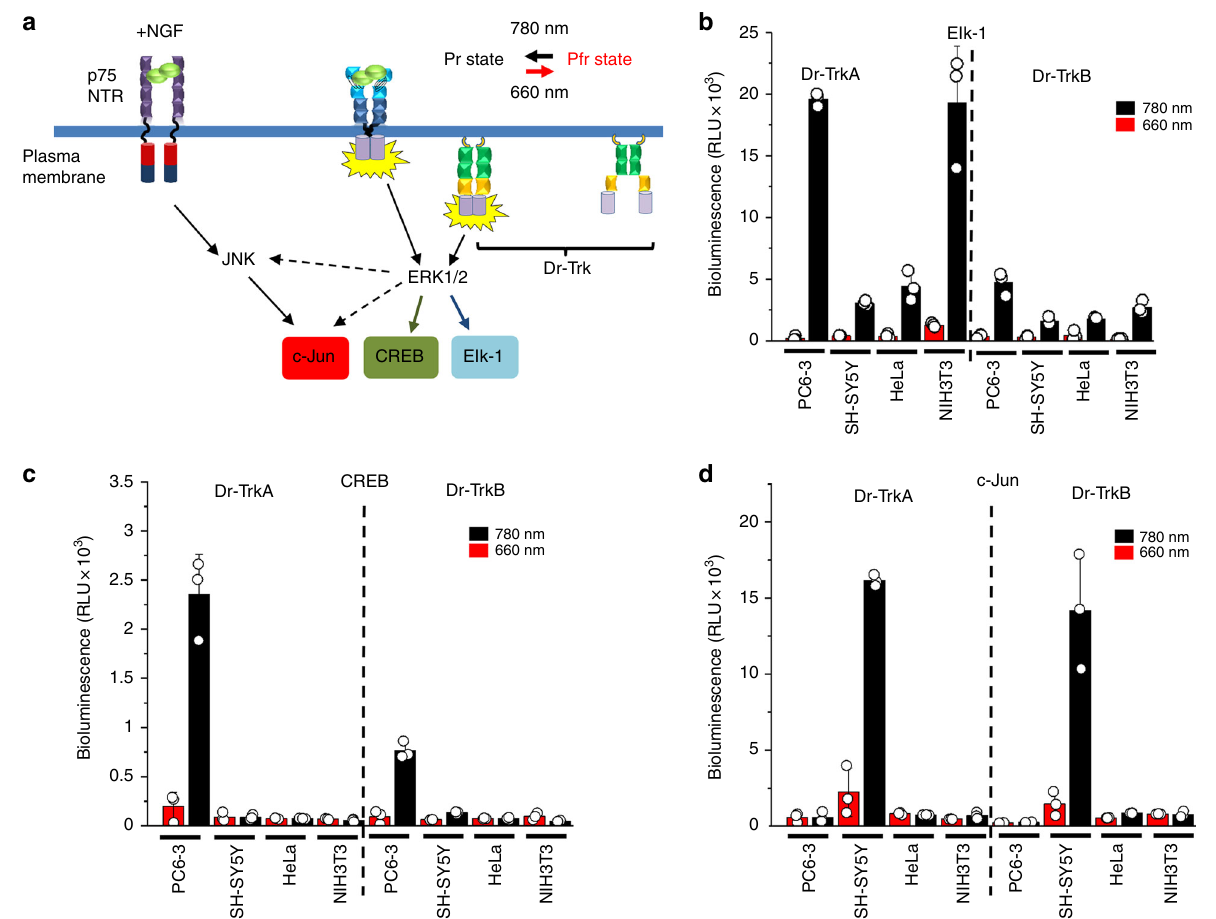
Fig. 2 Light-dependent activation of Elk-1, CREB, and c-Jun in various cell lines. a The scheme of the activation of Elk-1, CREB, and c-Jun transcription factors upon activation of the receptor tyrosine kinases (RTKs) and Dr-Trks. b Luciferase assay for Elk-1-dependent transcription in various cell lines. PC6-3, HeLa, SH-SY5Y, and NIH3T3 cells were plated in 24-well plate and incubated with the pCMVd2-Dr-Trk, pFR-Luc, and pFA-Elk-1 plasmid mixture (mass ratio 1:100:5 for PC6-3 or 1:100:1 for other cell lines) for 6 h. Medium then was replaced with serum-starving one, cells were grown for additional 30 h under 780 nm or 660 nm light (both 0.5 mW cm − 2 ), lysed, and analyzed for luciferase activity. c Luciferase assay for CREB-dependent transcription. The indicated cell lines were co-transfected with the pCMVd2-Dr-Trk, pFR-Luc, and pFA-CREB plasmid mixture (mass ratio 1:100:5 for PC6-3 or 1:100:1 for other cell lines), grown for 30 h under 780 nm or 660 nm light (both 0.5 mW cm − 2 ), lysed, and analyzed for luciferase activity. d Luciferase assay for c-Jun-dependent transcription. Cells were co-transfected with the pCMVd2-Dr-Trk, pFR-Luc, and pFA-c-Jun plasmid mixture (mass ratio 1:100:5 for PC6-3 cells or 1:100:1 for other cell lines), grown as above, and analyzed for luciferase activity. Error bars represent s.d., n = 3